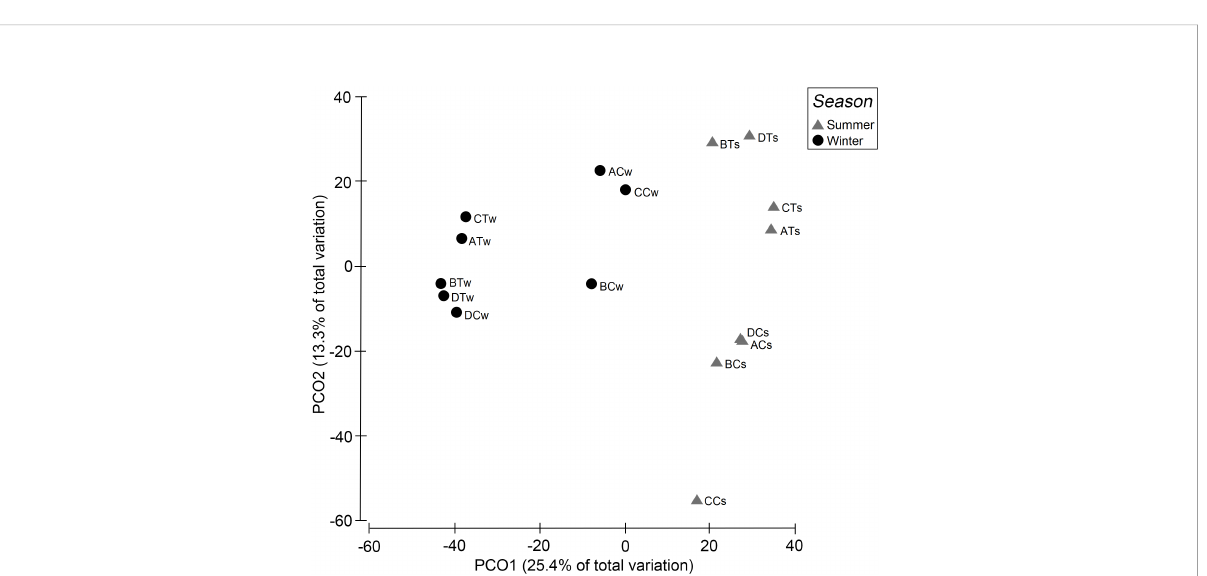
FIGURE 3 Principal coordinate analysis (PCoA) of the transformed pooled biomass (g/0.5 m 2 ) for treatments (AT-DT = trawled sites, AC-DC = non-trawled sites) and seasons (s, summer; w,